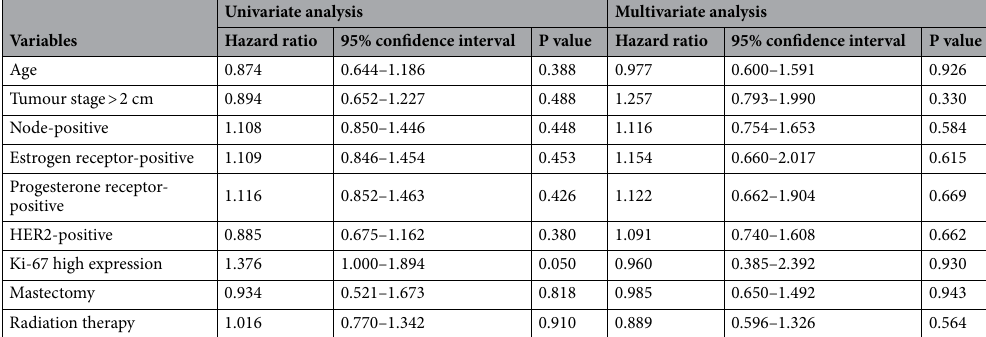
Table 2. Cox regression analysis for disease-free survival in southern